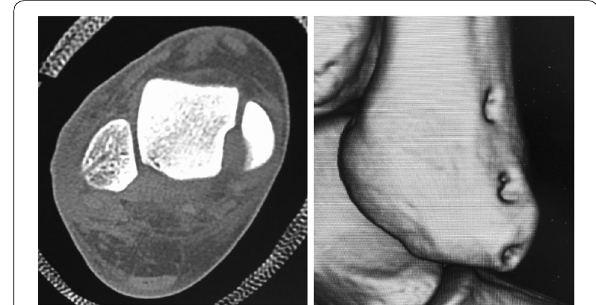
Fig. 6 Postoperative CT image. Postoperative CT image showing the position and direction of the anchor